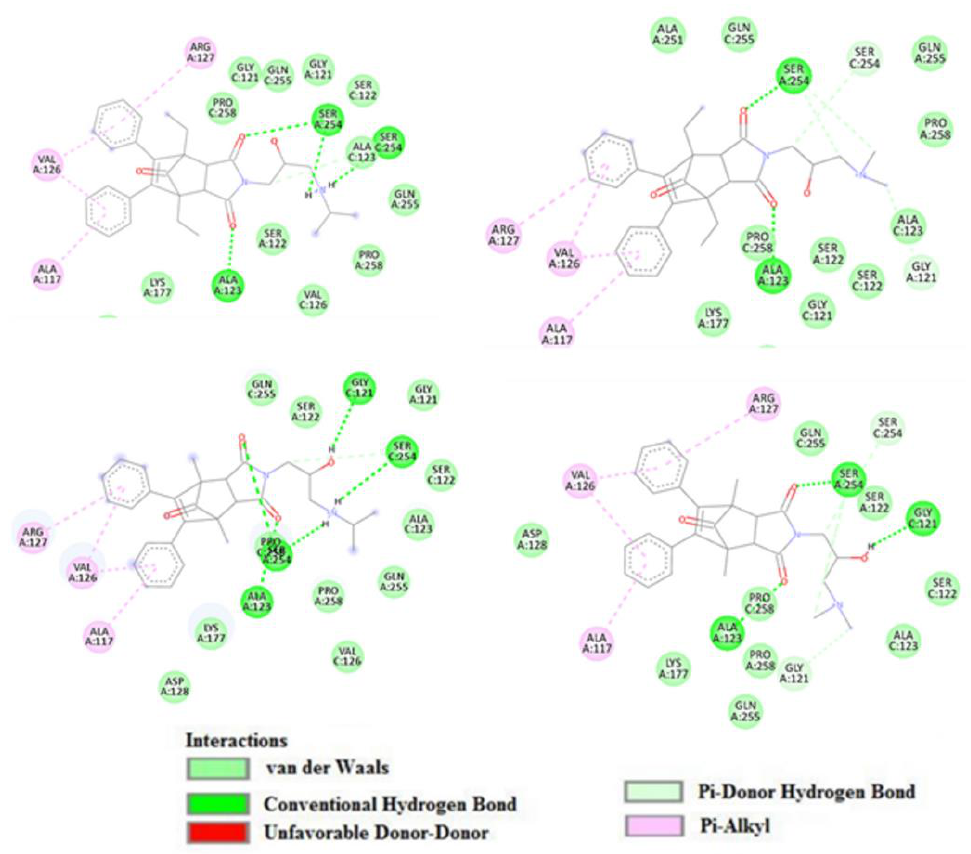
Figure 6. Bioactive conformation of compound III.